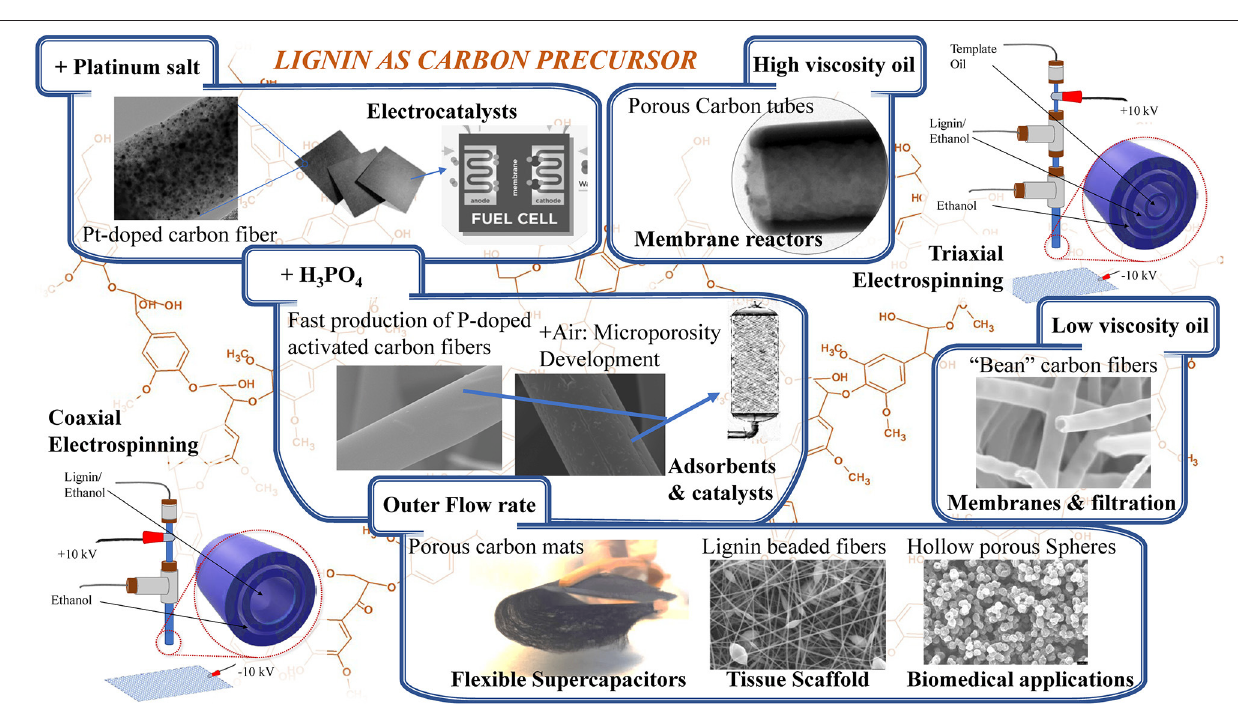
Frontiers in Materials |